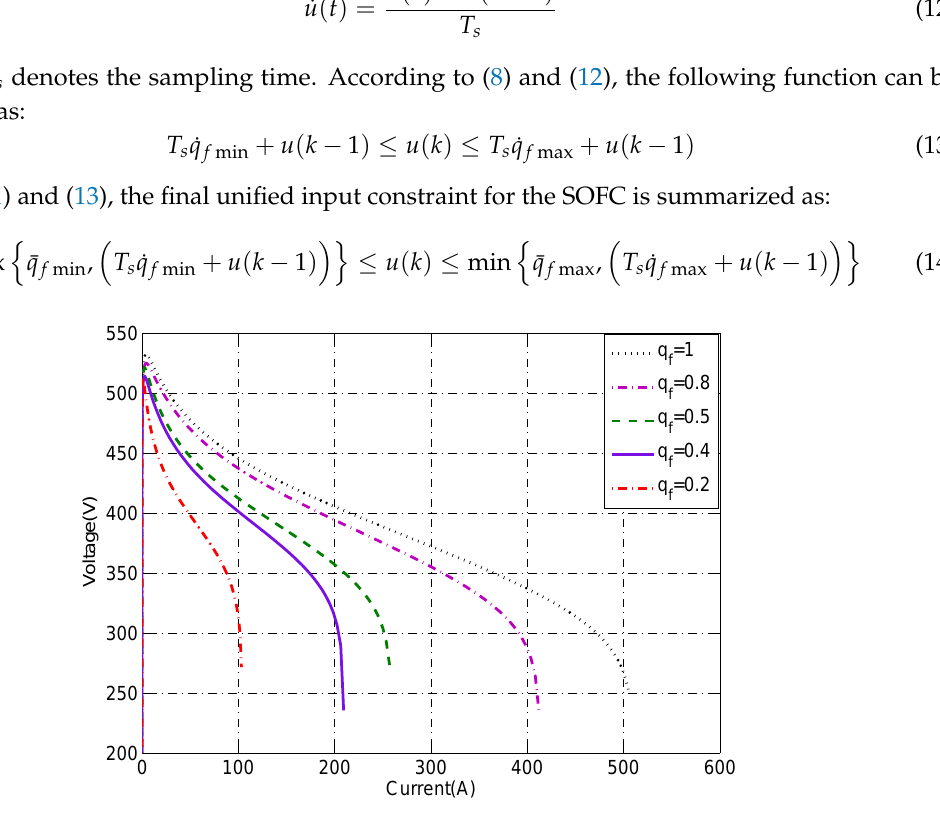
Figure 3. Volt-ampere characteristics for the SOFC